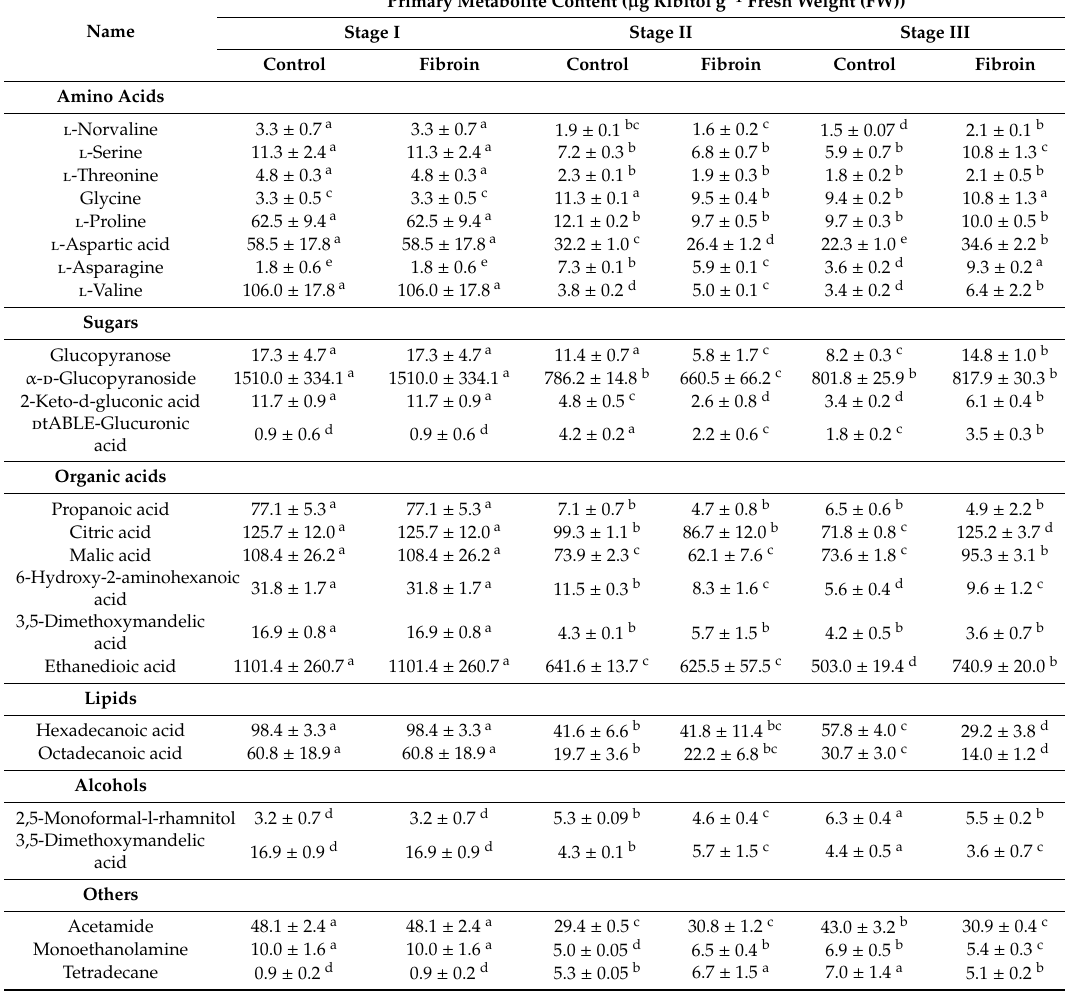
Table 2. The content of primary metabolites in peels of harvested banana fruit during cold storage. The data are presented as means ± standard errors ( n = 3). The means with di ff erent letters are significantly di ff erent ( p <